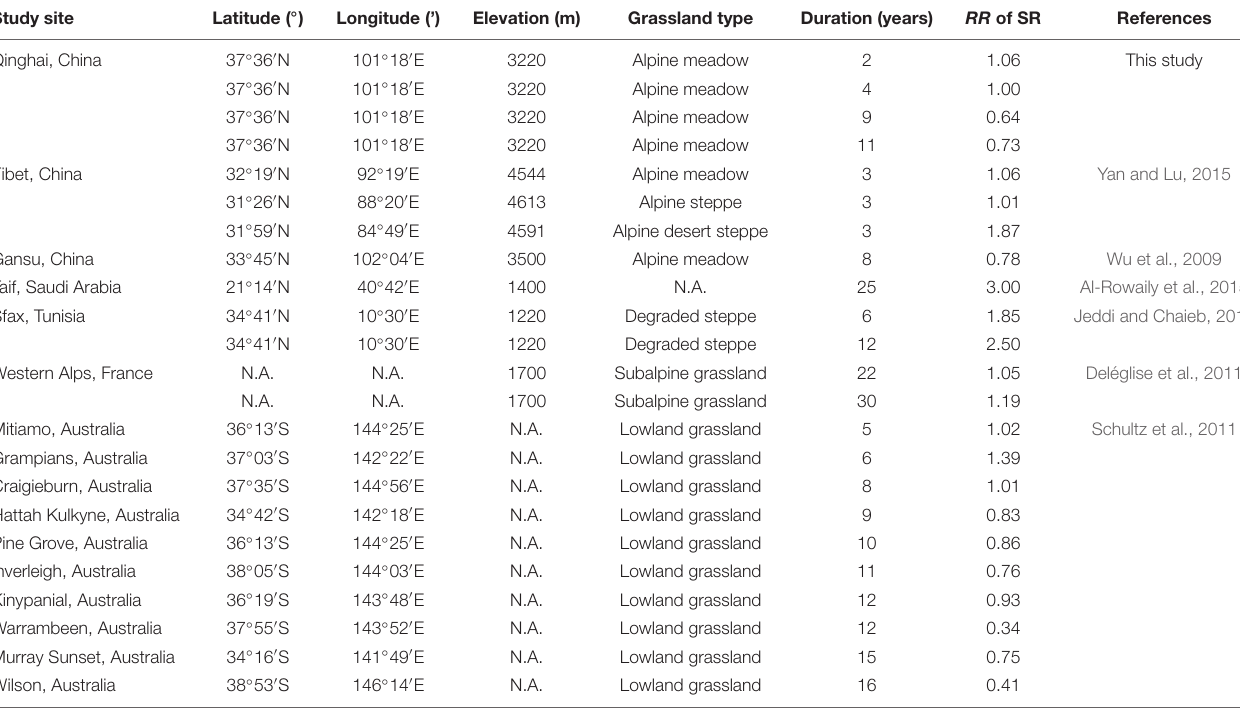
TABLE 2 | Effect of grazing exclusion on grassland plant species richness in this and other